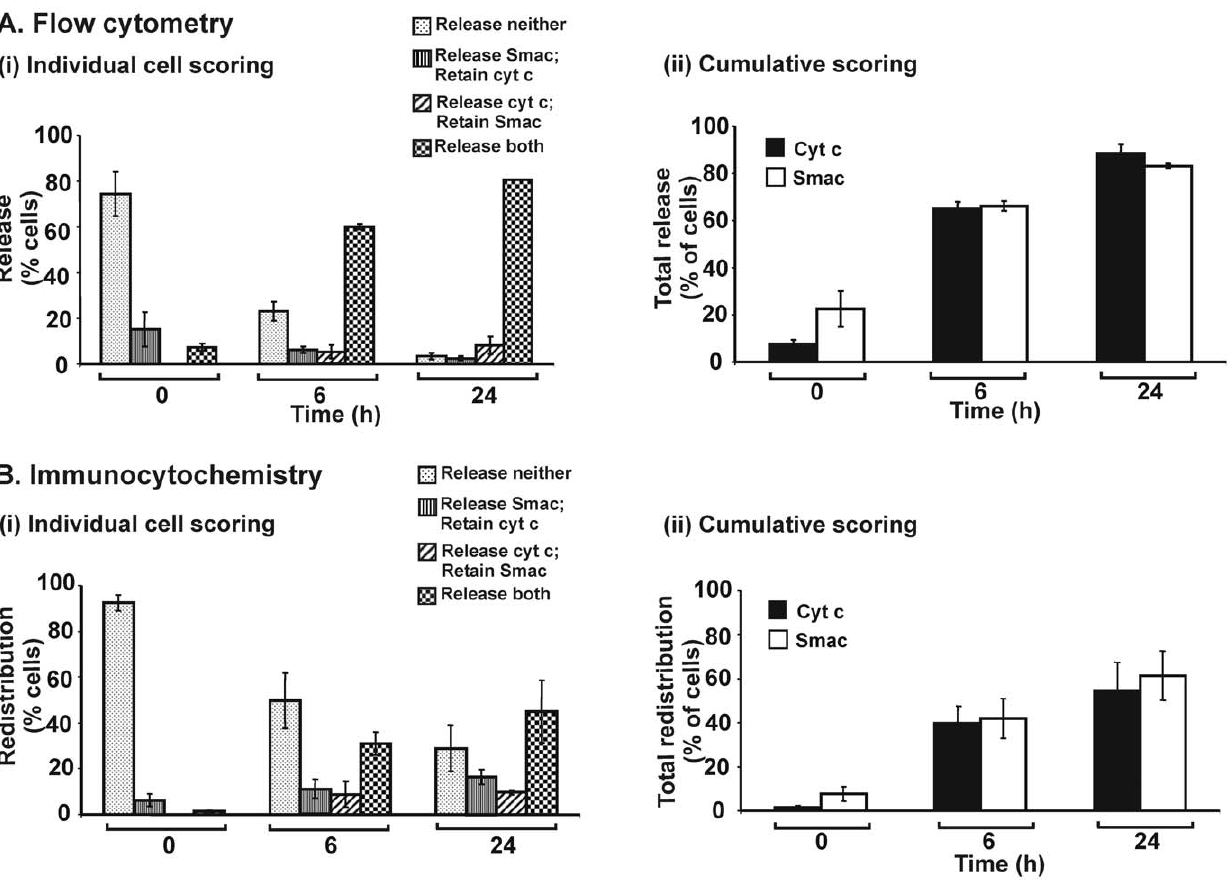
Figure 5. Simultaneous redistribution of cyt c and Smac in HeLa cells treated with STS. HeLa cells were untreated or treated with STS (300 nM) for various times. All other indications as for Figure 4.